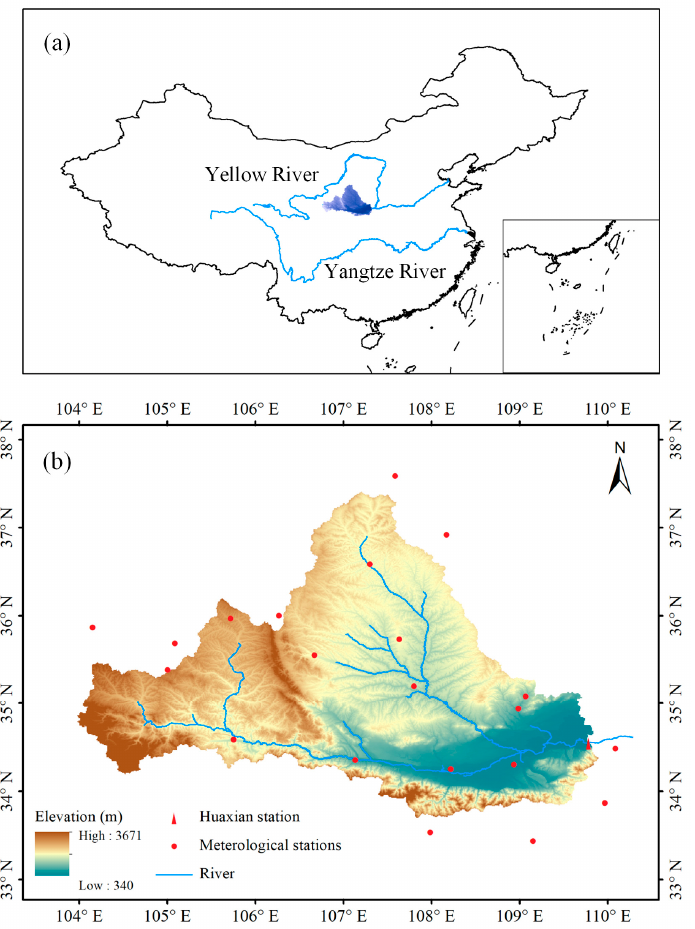
Figure 1. Location of Weihe River Basin (WRB) in China ( a ) and stations with hydrological and meteorological measurements ( b ).